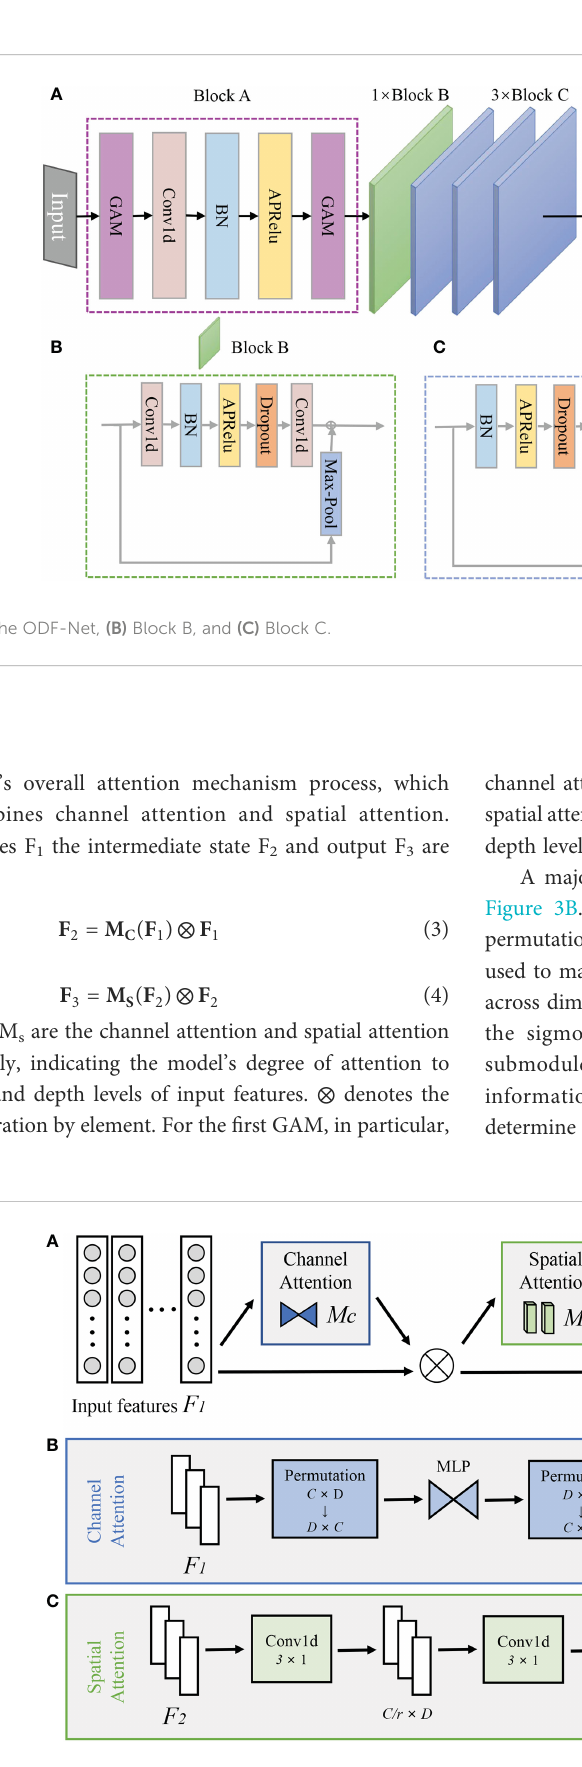
FIGURE 3 (A) The overview of redesigned GAM. The structures of (B) channel attention submodule, and (C) spatial attention